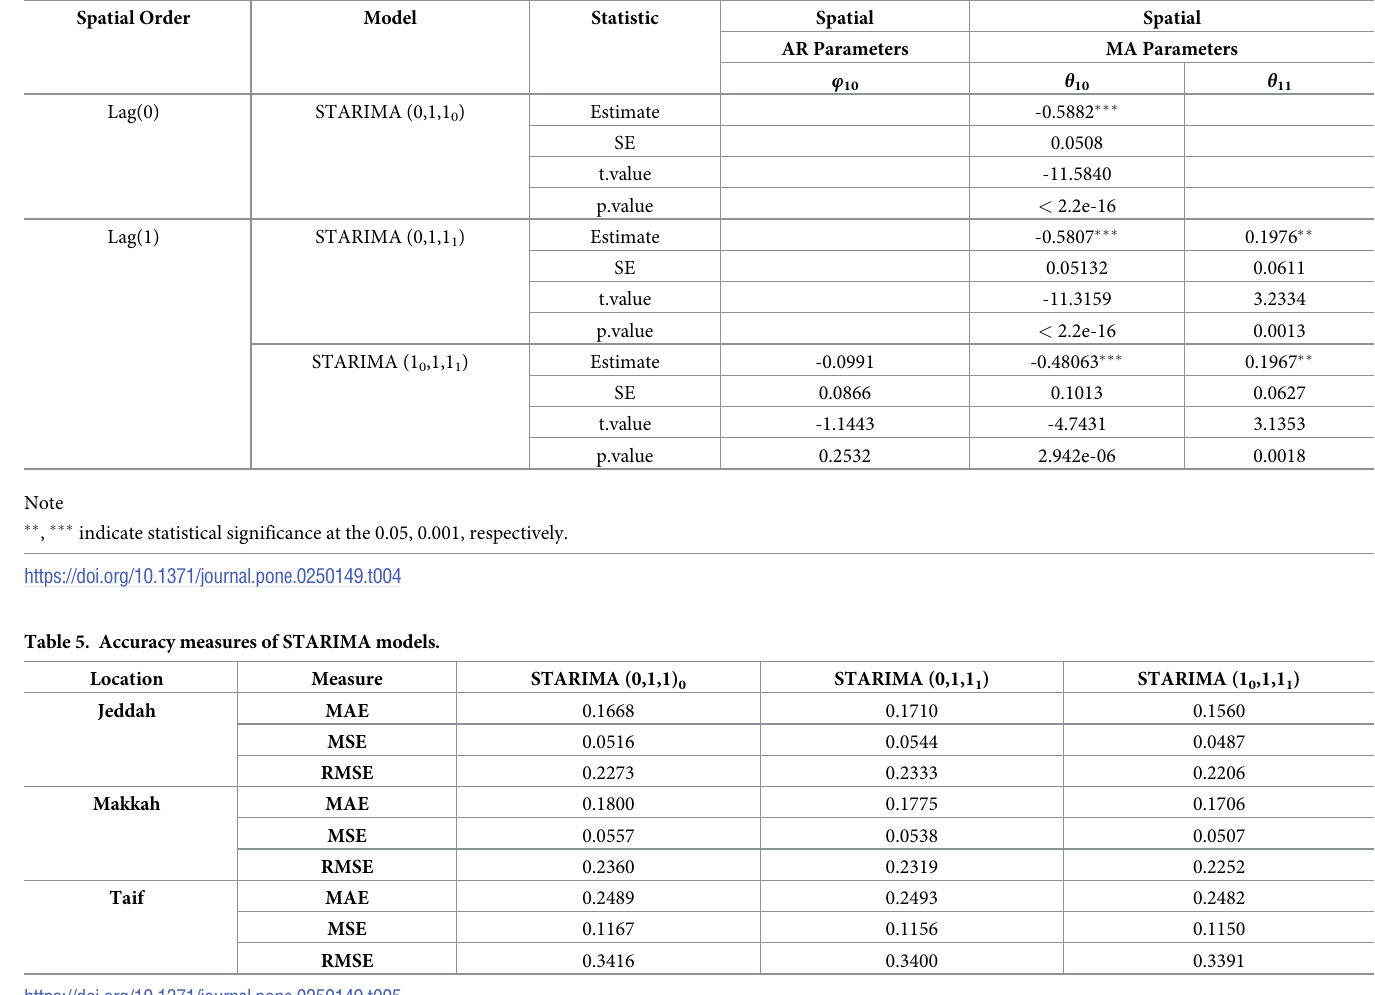
Table 4. The results of the estimated STARIMA models.